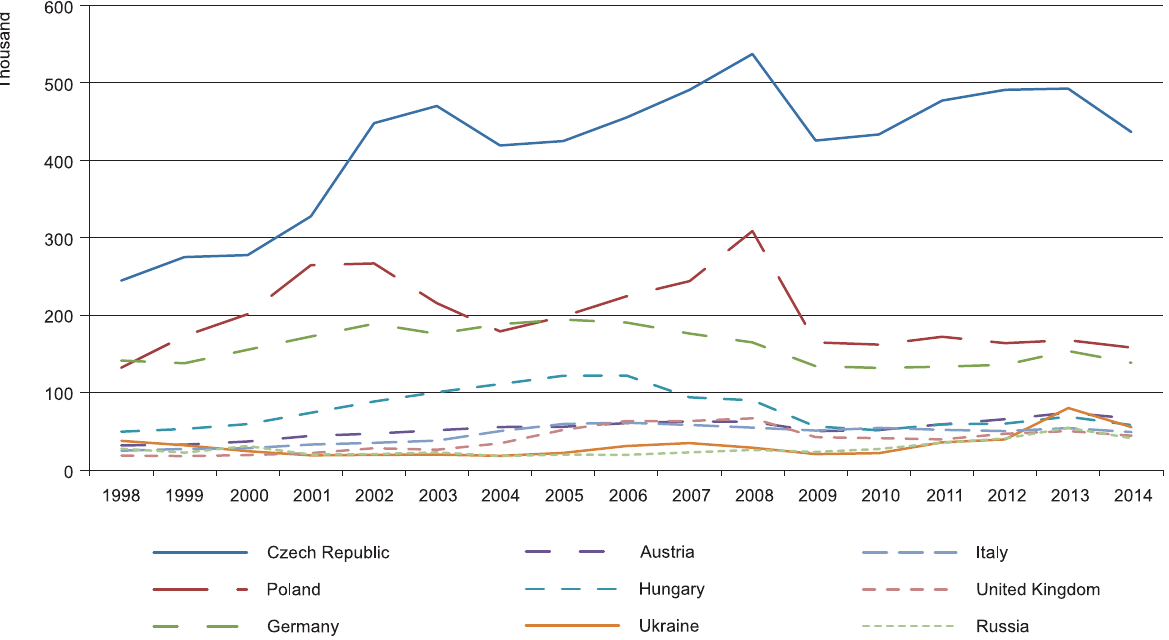
Fig. 2. Structure of foreign tourists in Slovakia,